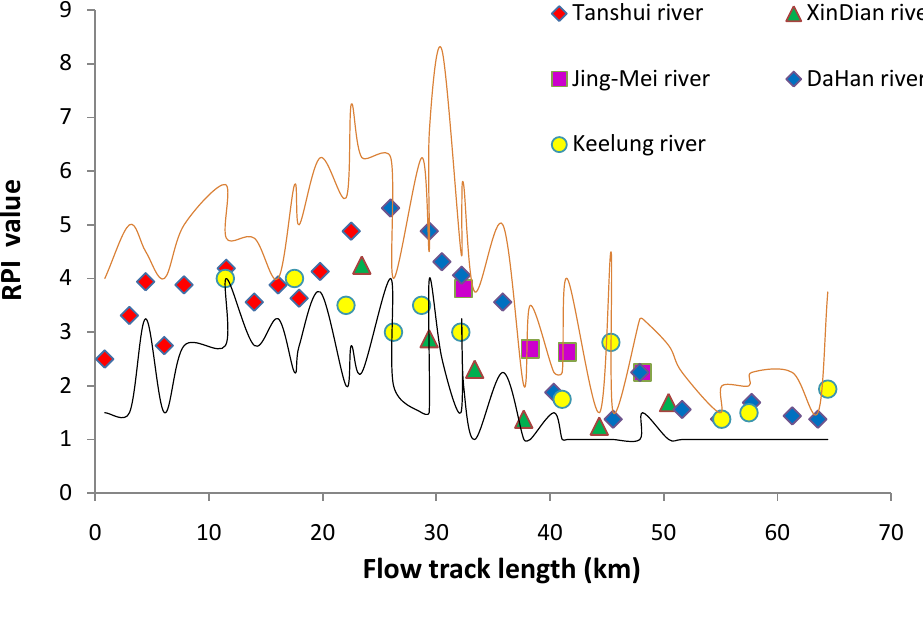
Figure 2. The RPI value of the Tanshui River system in 2012. The point marks indicate the mean of four seasons, red line was upper limit and black line was lower limit. RPI under 2 Non-impaired, RPI 2.0–3.0 Slightly impaired, RPI 3.1–6.0 moderately impaired, and RPI above 6 means severely